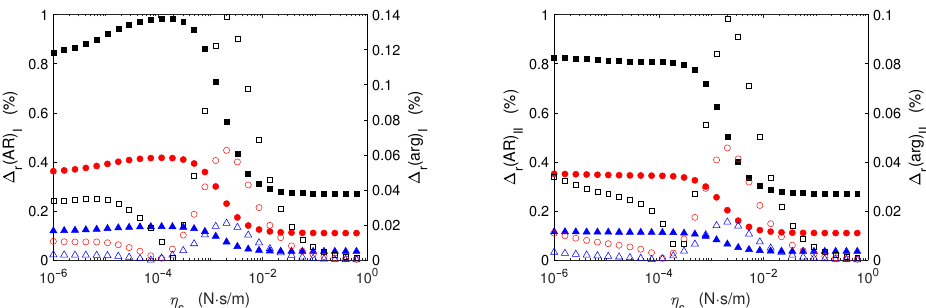
Figure 8. Relative differences in modulus, ∆ r ( AR ) (solid symbols), and phase, ∆ r ( arg ) (open symbols), between the solutions obtained with different mesh sizes taking as a reference the 2520 × 1260 mesh solution. Black symbols: 200 × 100 mesh. Red symbols: 440 × 220 mesh. Blue symbols: 1000 × 500. Left panel: PV-I; right panel: